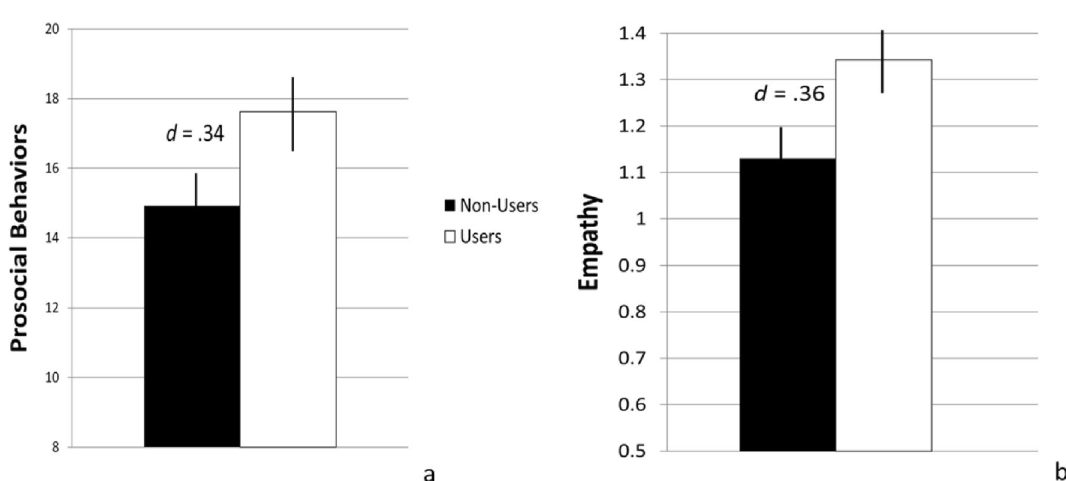
Figure 2. Group differences in prosocial behaviors and empathy quotient construct scores. Note. The prosocial behaviors scores ranged from − 8 to 32 and empathy scores − .15 to